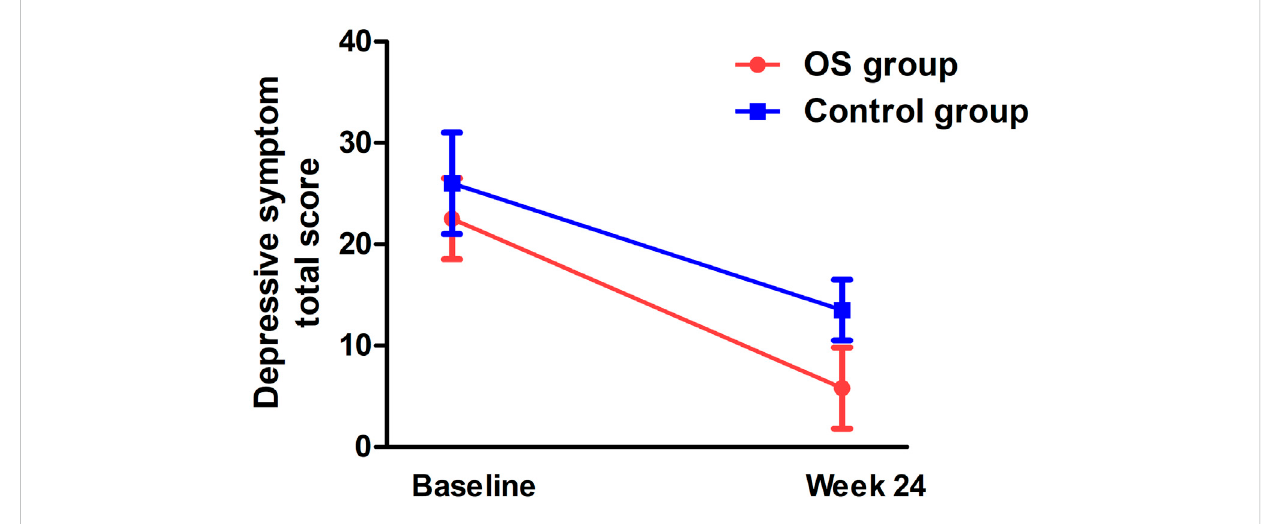
FIGURE 3 Interaction effect of group and time on depressive symptoms in TRS patients ( p <